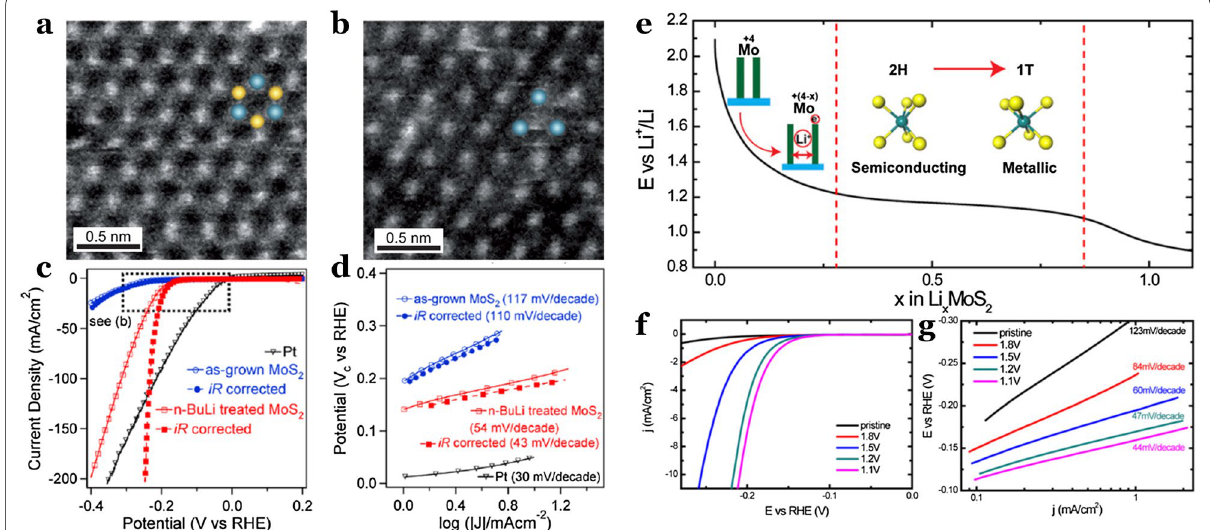
Fig. 7 Dark-field scanning transmission electron microscopy images of a 2H-MoS 2 , and b 1T-MoS 2 . c Polarization curves of the 2H- and 1T-MoS 2 for the HER, and d the corresponding Tafel plots. Filled symbols indicate the iR-corrected data. e Galvanostatic discharge curve representing the lithiation process. f Polarization curves of the pristine and lithiated MoS 2 for the HER, and g the corresponding Tafel plots (Figures reprinted with permission from Refs. [9, 26,